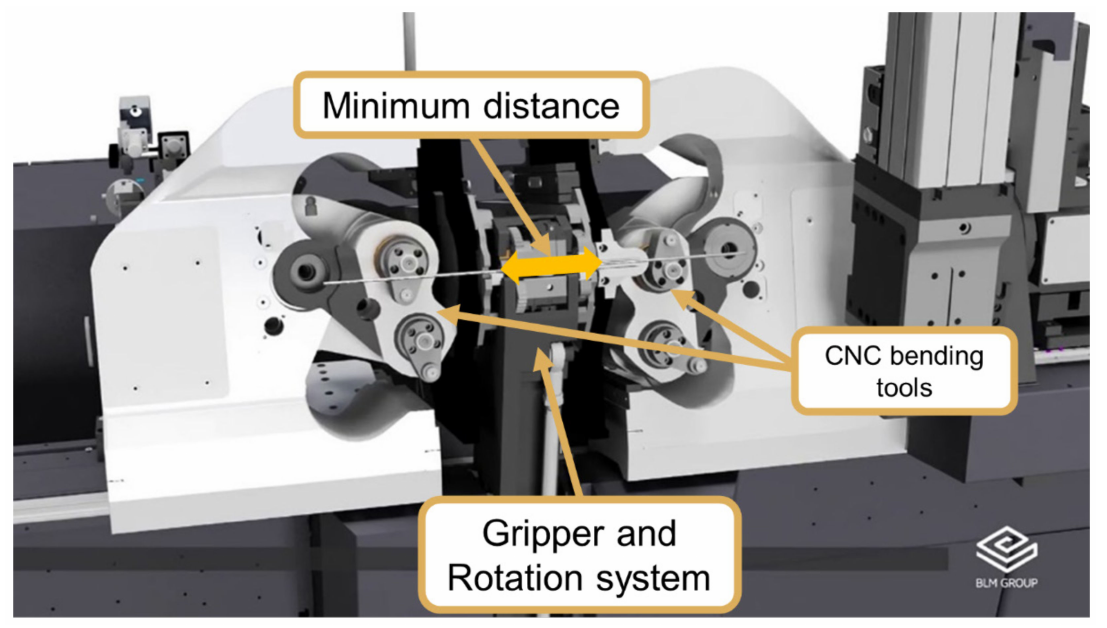
Figure 8. Central part of the equipment DH4012 VGP (BLM Group).